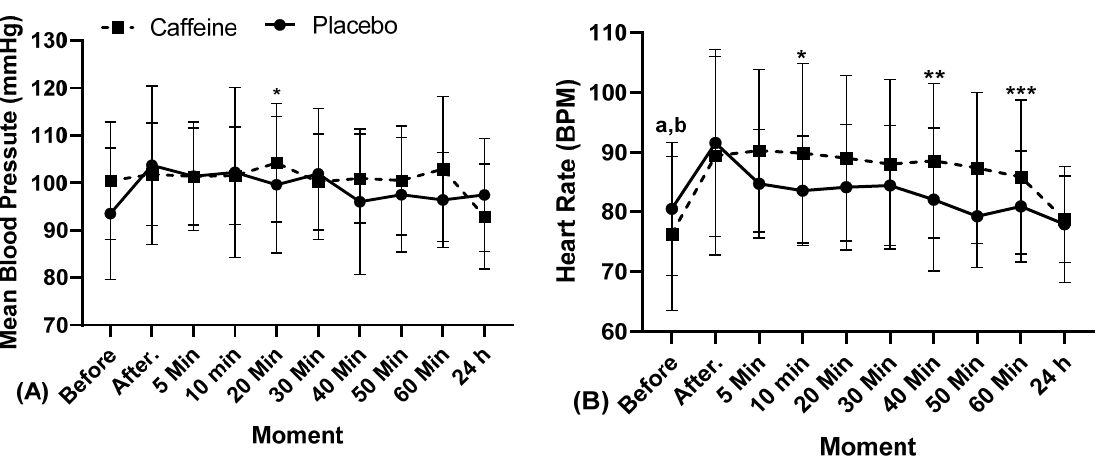
Figure 3. Cardiovascular response after resistance exercise with caffeine and placebo in relation to Mean Blood Pressure, Heart Rate, at different times, min: Minutes; h: Hours. “*”, “**” and “***” indicate interclass, and “a” and “b” indicate the intraclass difference.